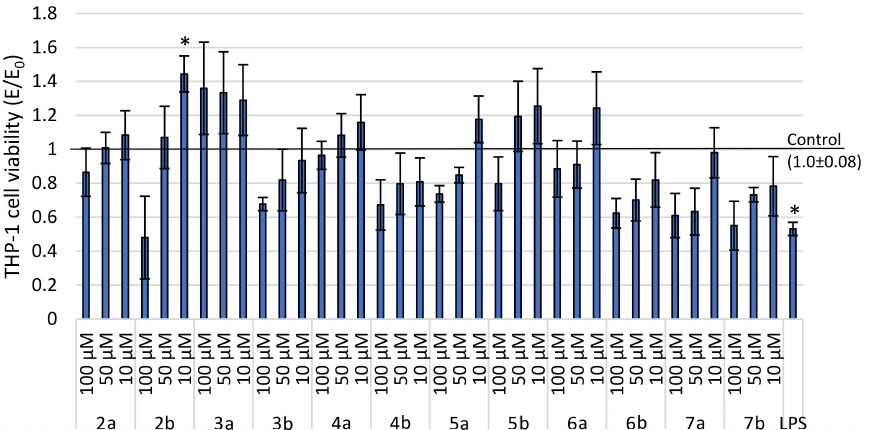
Figure 4. Impact of investigated compounds on THP-1 cells measured through MTT assay; * p < 0.05— significant difference compared to control with 50 µ g/mL LPS and without